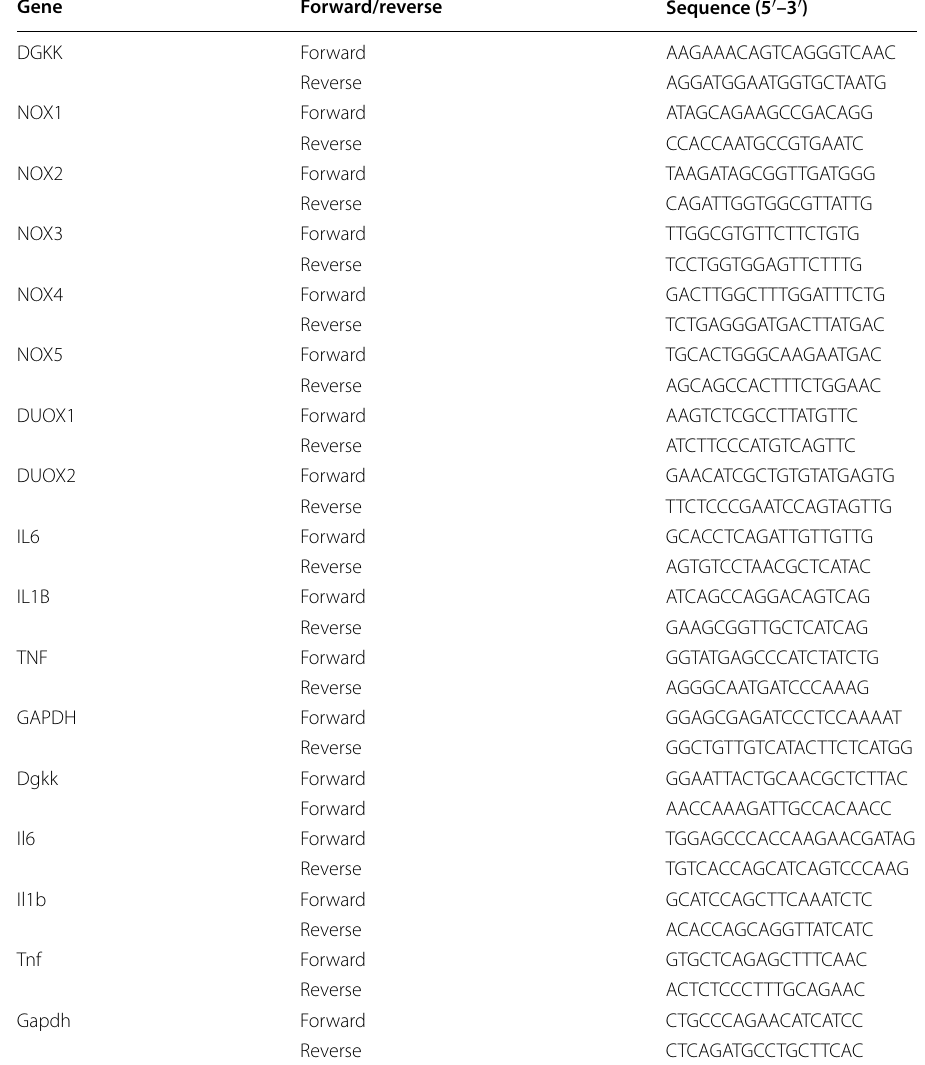
Table 1 Primer sequences used in the study Gene Forward/reverse Sequence (5 ′ –3 ′